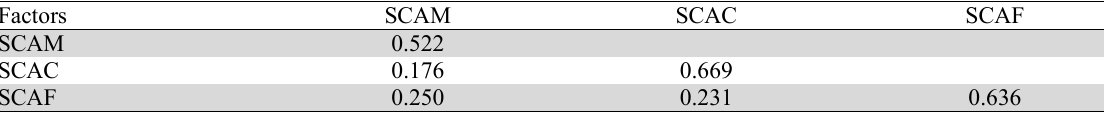
Fig. 1 exemplifies the proposed structural model showing the association between the five and three dimensions of DC and SCA, respectively. To examine the model, conventional maximum likelihood estimation approaches were used (Martínez-Costa & Jiménez-Jiménez, 2009). It is assessed the measurement model fit by evaluating: (1) absolute fit indices including observed normed χ 2 ( χ 2 /df), goodness of fit index (GFI), adjusted goodness-of-fit index (AGFI) and adjusted goodness-of-fit index (AGFI); (2) Comparative fit indices including normed fit index (NFI), and comparative fit index (CFI); and (3) parsimonious fit indices including parsimony goodness-of-fit index (PGFI) and parsimony normed fit index (PNFI) and the root mean square error of approximation (RMSEA). The